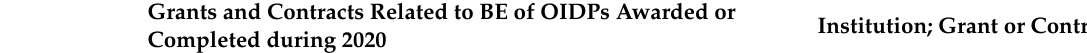
Table 1. Summary of the generic drug science and research initiatives related to orally inhaled drug products (OIDPs) funded by the Generic Drug User Fee Act (GDUFA) in